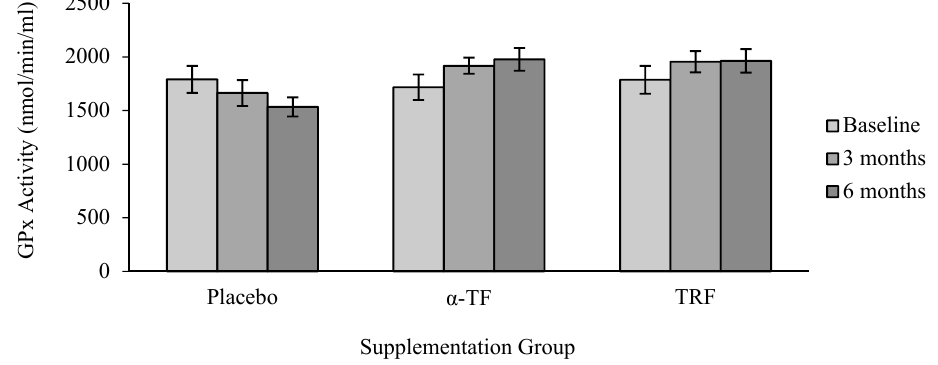
Figure 5. Effect of α -TF and TRF supplementation on glutathione peroxidase (GPx) activity for 6 months. GPx activity remained unchanged throughout the study with both supplements.